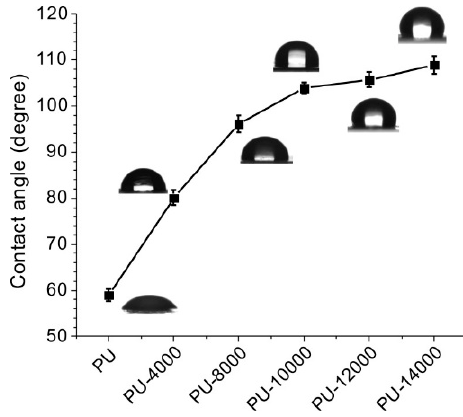
Figure 5. Plot of surface water contact angles of the organic–inorganic hybrid PUs.